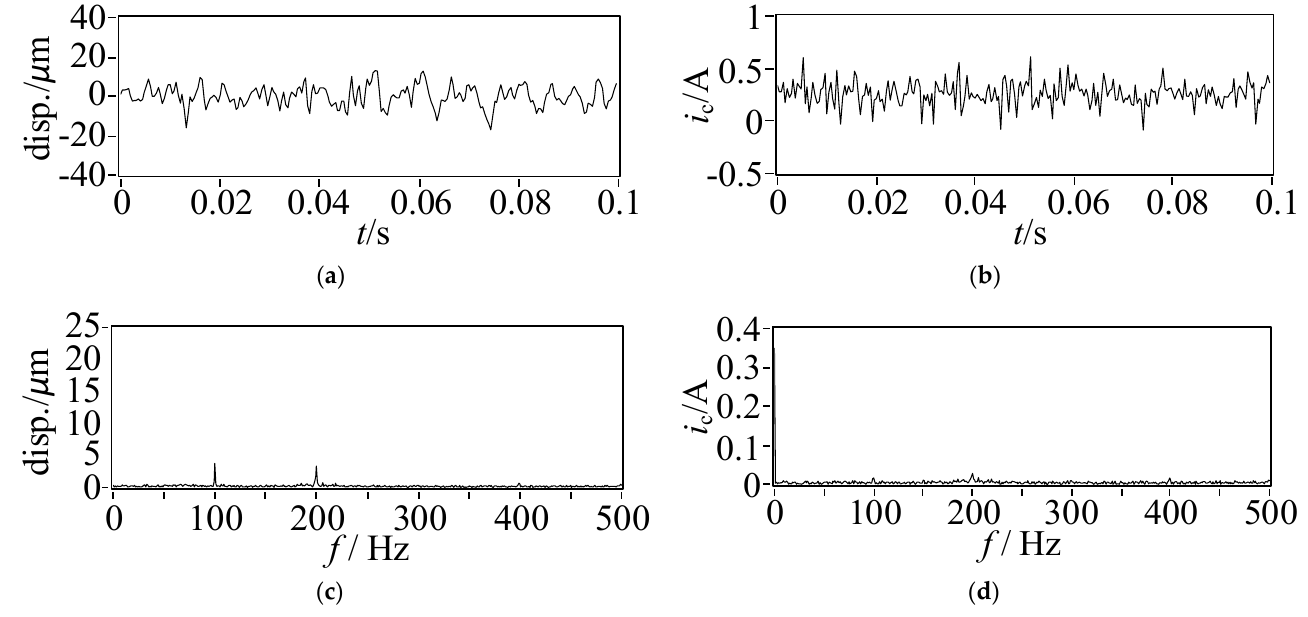
Figure 10. The amplitude-frequency diagram of displacement and current after rotor LMS compen- sation. ( a ) Time domain spectrum of displacement; ( b ) Time domain spectrum of current; ( c ) Fre- quency spectrum of displacement; ( d ) Frequency spectrum of current.